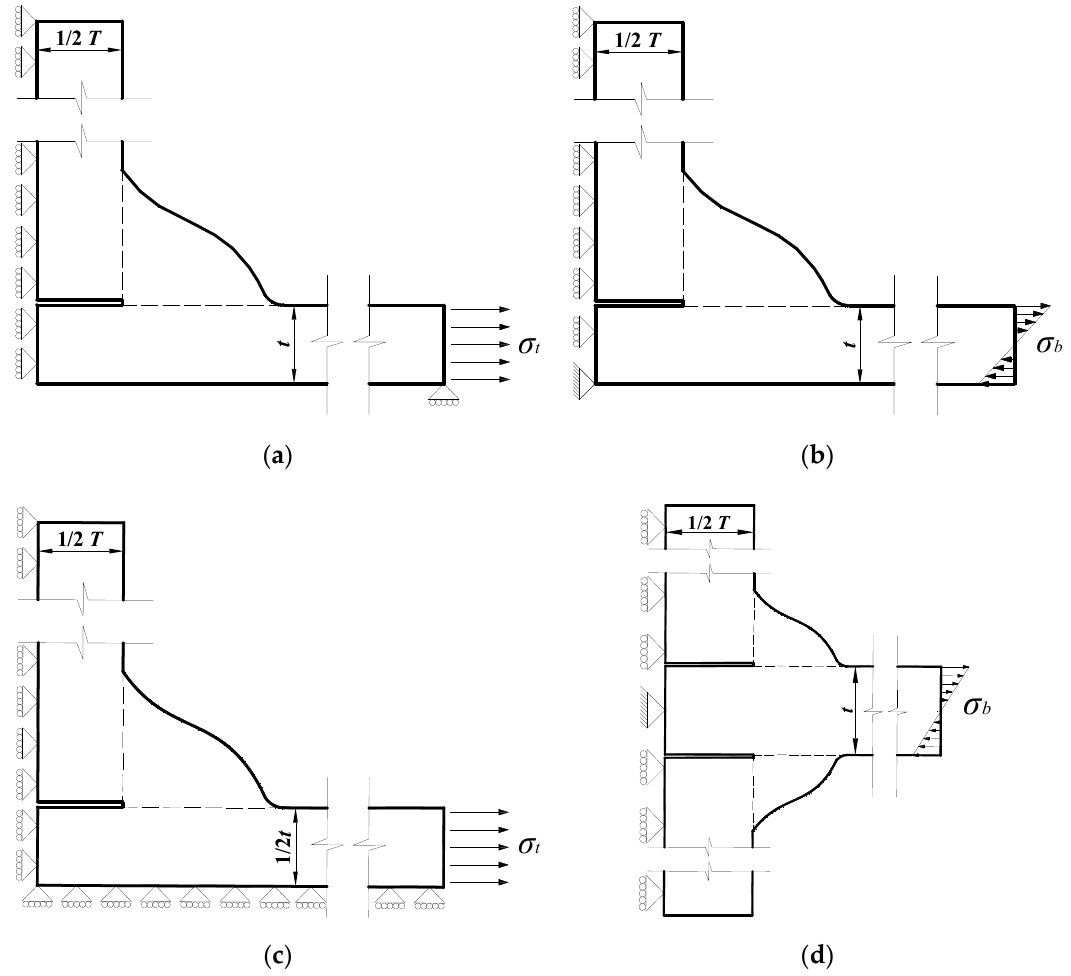
Figure 2. Boundary and loading conditions: ( a ) T-shape joint (tensile stress); ( b ) T-shape joint (bending stress); ( c ) cruciform joint (tensile stress); ( d ) cruciform joint (bending stress).